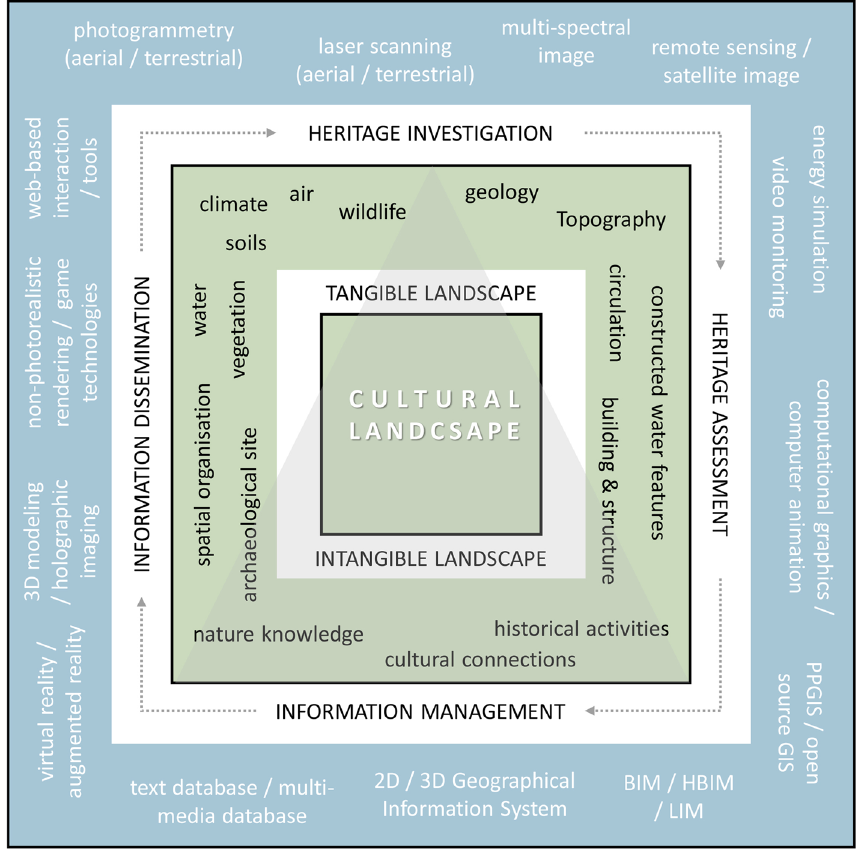
Fig. 1 A theoretical framework for digital cultural landscape information system (Source: the